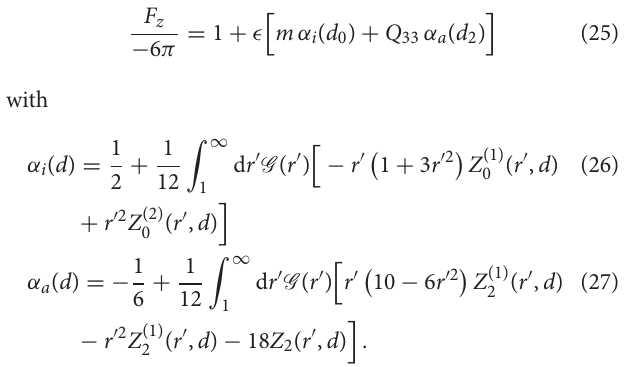
of the zero crossing we look at the specific quadrupole